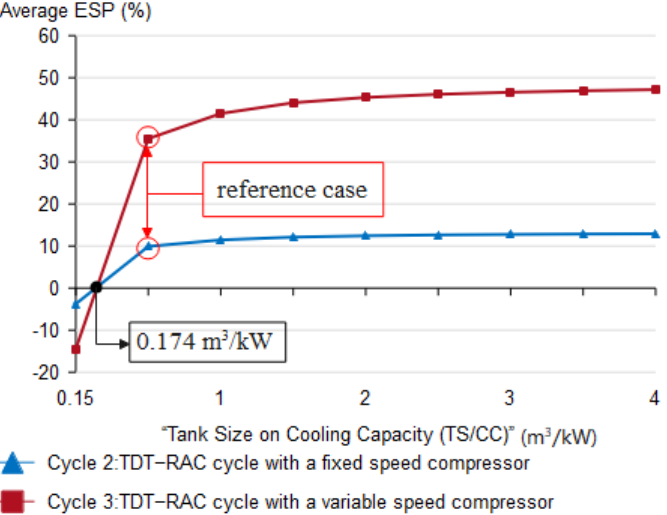
Figure 11. Average ESP versus “Tank Size on Cooling Capacity (TS/CC)” (the threshold of both TDT-RAC cycles is the same, which is about 0.174 m 3 /kW).